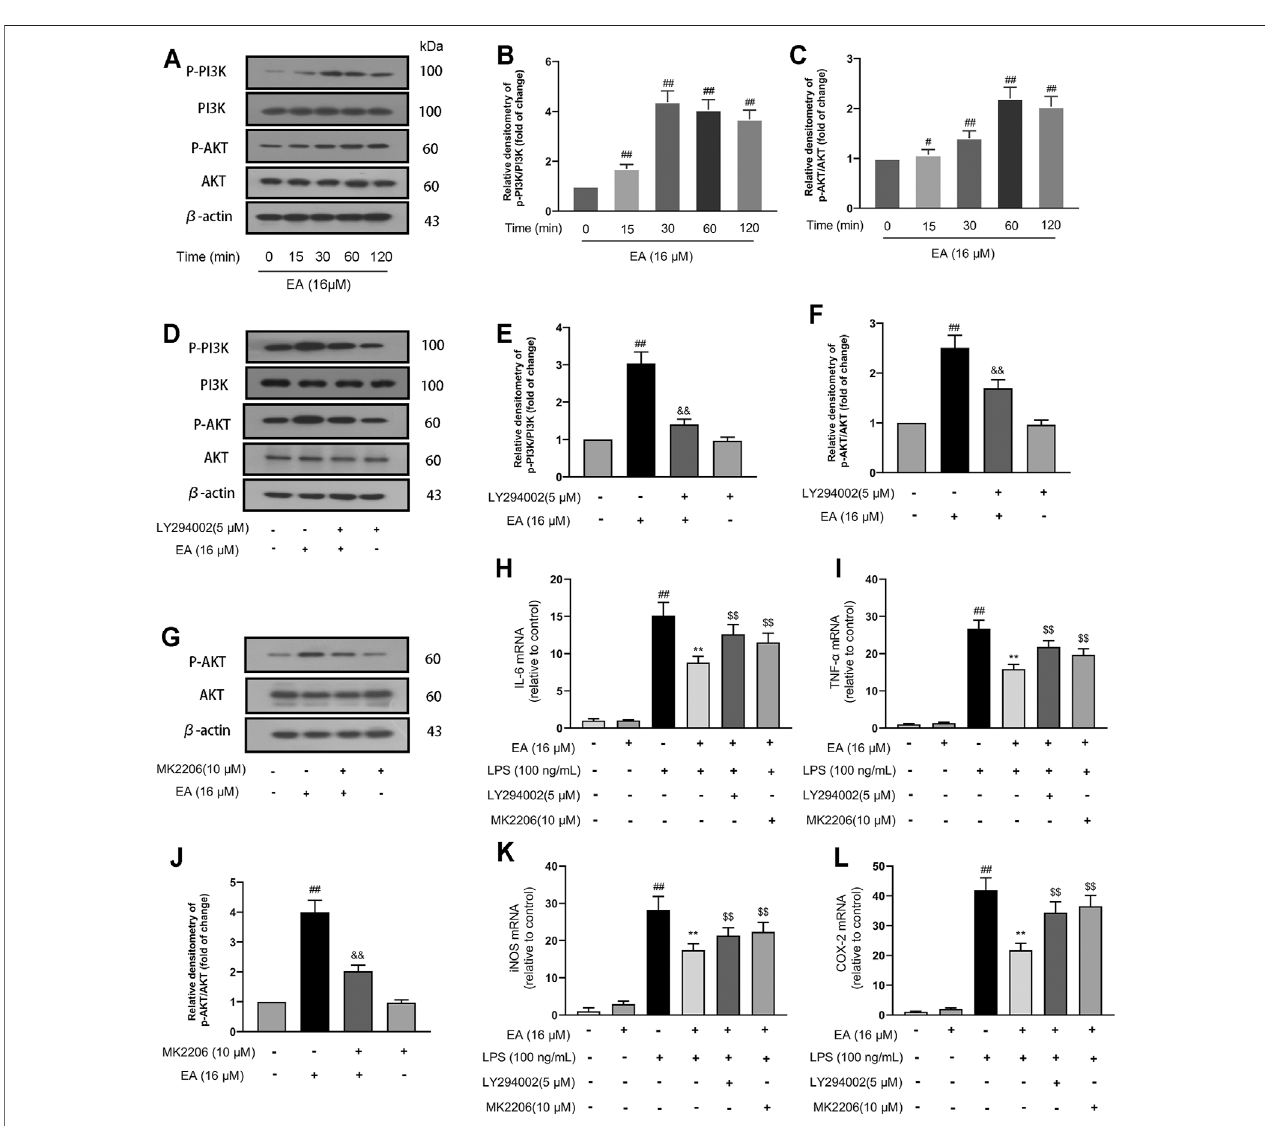
FIGURE 3 | EA inhibits in fl ammation through the PI3K/Akt signal pathway. We treated BV2 cells for 1 h with EA (16 μ M) and stimulated for 12 h with LPS (100 ng/ ml). BV2 cells were treated for different times (0, 15, 30, and 60 min) with EA (16 μ M), and then the protein expression of p-PI3K, PI3K, p-Akt, Akt, and β -actin was examined via Western blot experiment (A – C) . BV2 cells were treated for 6 h with LY294002 (a PI3K pathway inhibitor, 5 μ M) or MK2206 (an Akt pathway inhibitor 10 μ M),andthentheproteinexpressionofp-PI3K,PI3K,p-Akt,Akt,and β -actinwasexamined via Westernblotexperiment (D – H) .Thereafter,wetreatedBV2cells for1 hwithEA(16 μ M)andstimulatedfor12 hwithLPS(100 ng/ml),andthensurveyedtheeffectofEAonthemRNAlevelsofin fl ammatorymediators[iNOS (K) ,COX-2 (L) , IL-6 (I) , and TNF- α (J) ] via quantitative PCR experiment. Results are represented as means ± SD ( n (cid:1) 4). ## p < 0.01 vs. control group. **p < 0.01 vs. LPS-exposed group. $$ p < 0.01 vs. LPS + EA